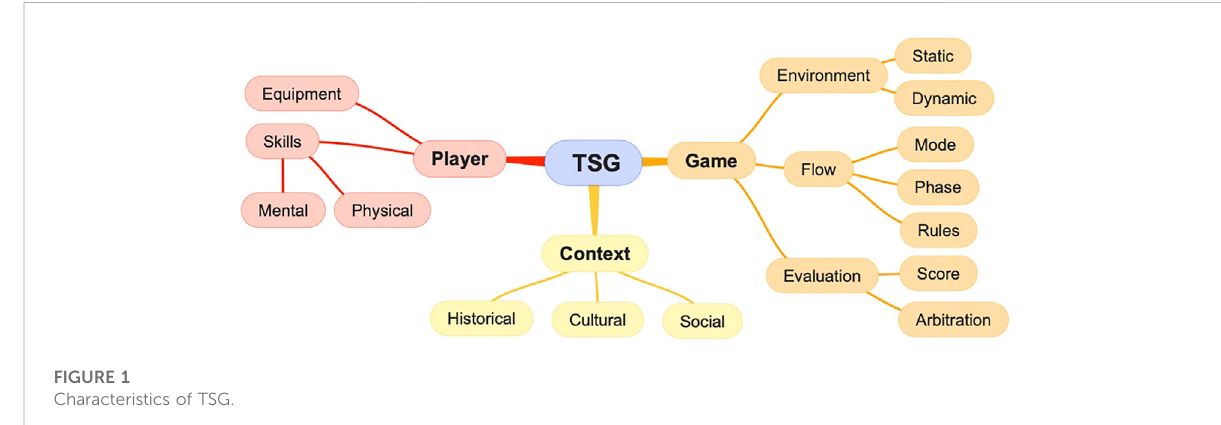
FIGURE 1 Characteristics of TSG.